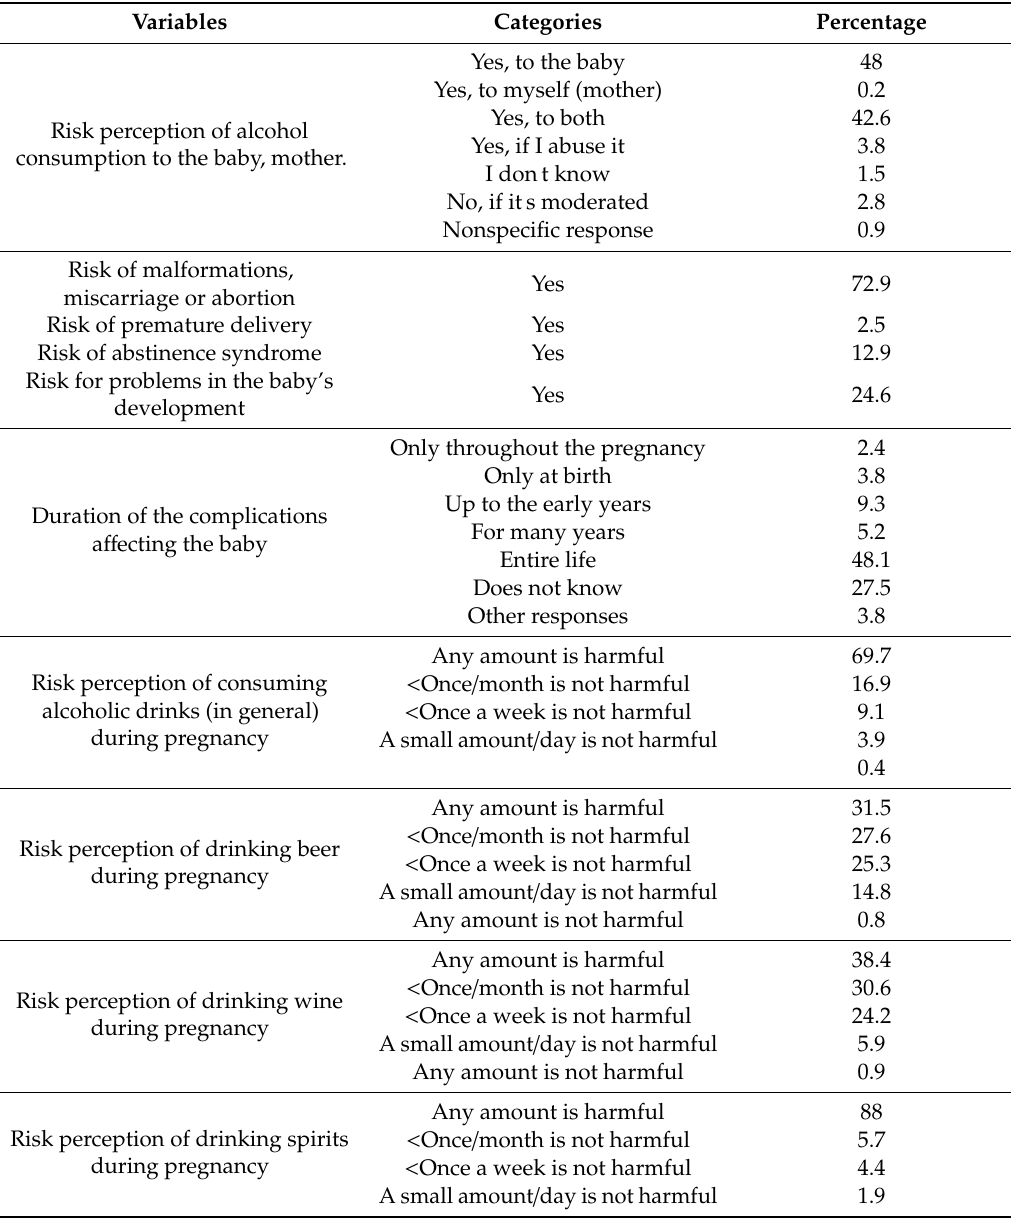
Table 2. Risk perception of alcohol consumption during